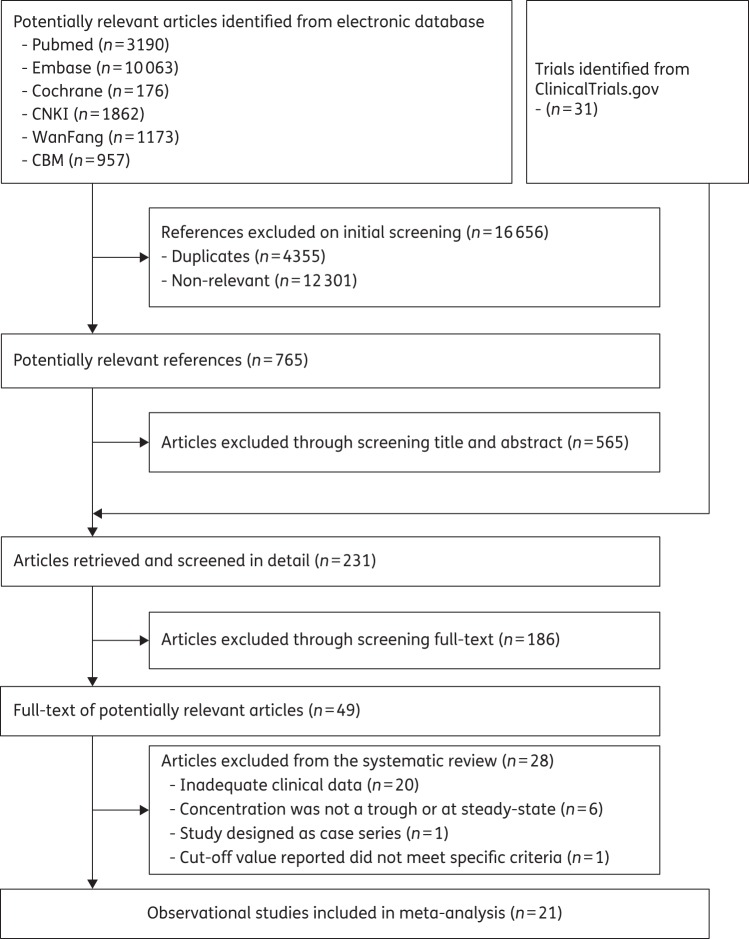
Flow chart of study selection.